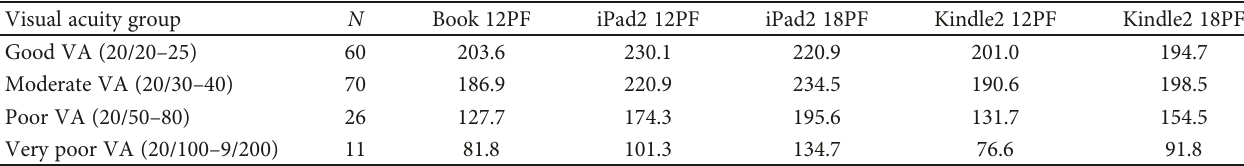
Table 2: Visual acuity group and mean reading speed.